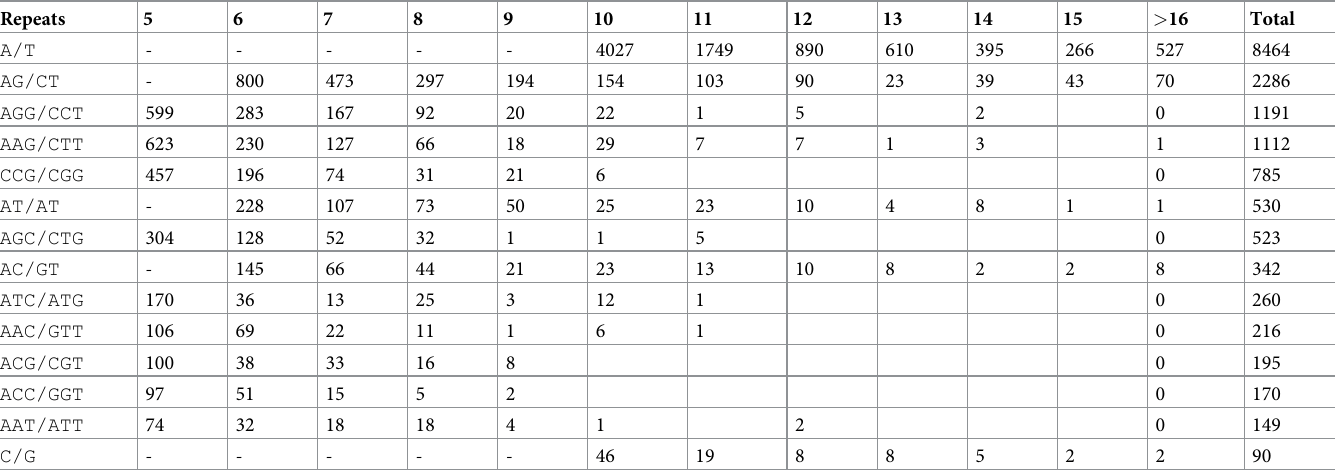
Table 2. Frequency distribution of the 12 most frequent EST-SSR repeat motifs in